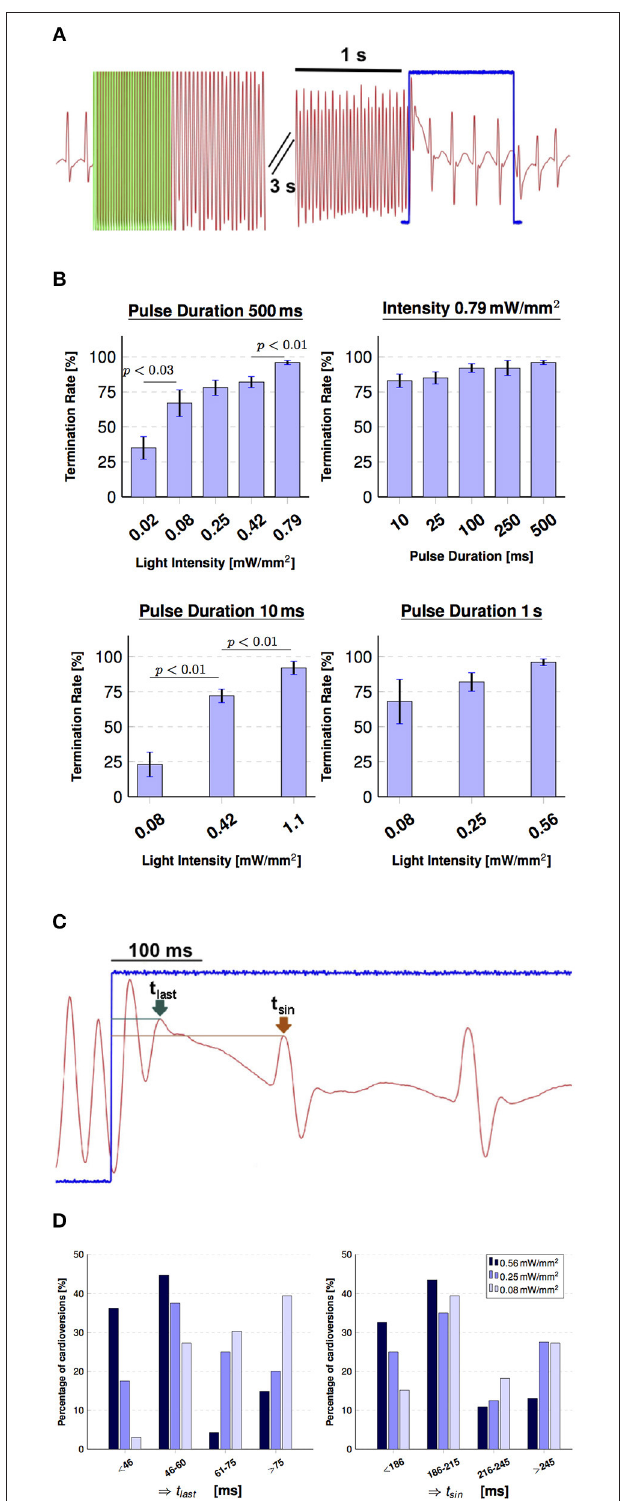
FIGURE 4 | Global illumination for cardioversion. (A) Shows the pseudoECG signal during arrhythmia evocation via electrical pacing and termination using global illumination (green overlay indicates electrical pacing at 50Hz, 30